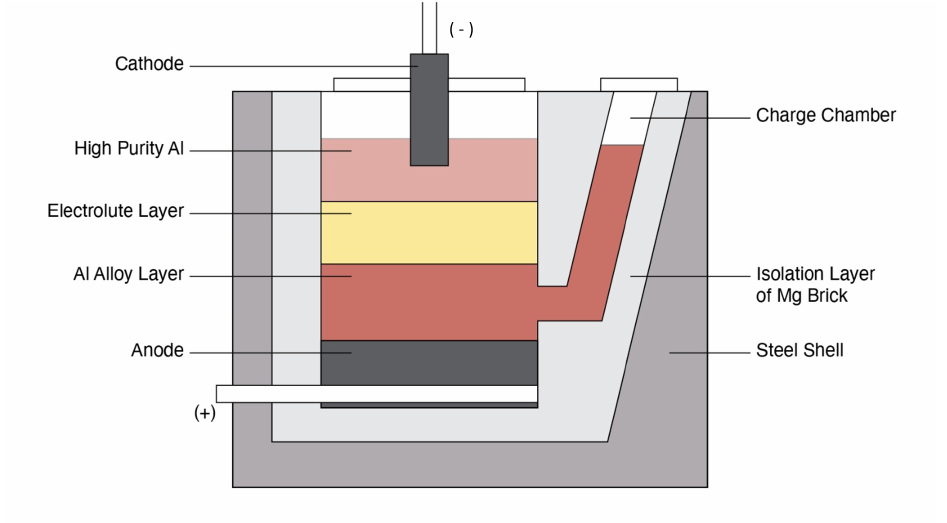
Figure 2. Structural sketch of three-layer electrolytic cell, data from [24].